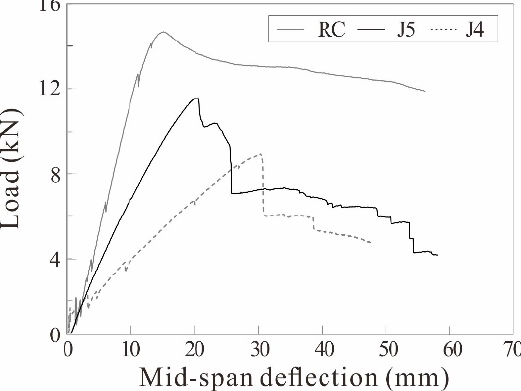
Figure 18. Comparison of the maximum load between the specimens reinforced with carbon grids and steel, based on: ( a ) tensile force; and ( b ) flexural strength. and steel, based on: ( a ) tensile force; and ( b ) flexural strength.